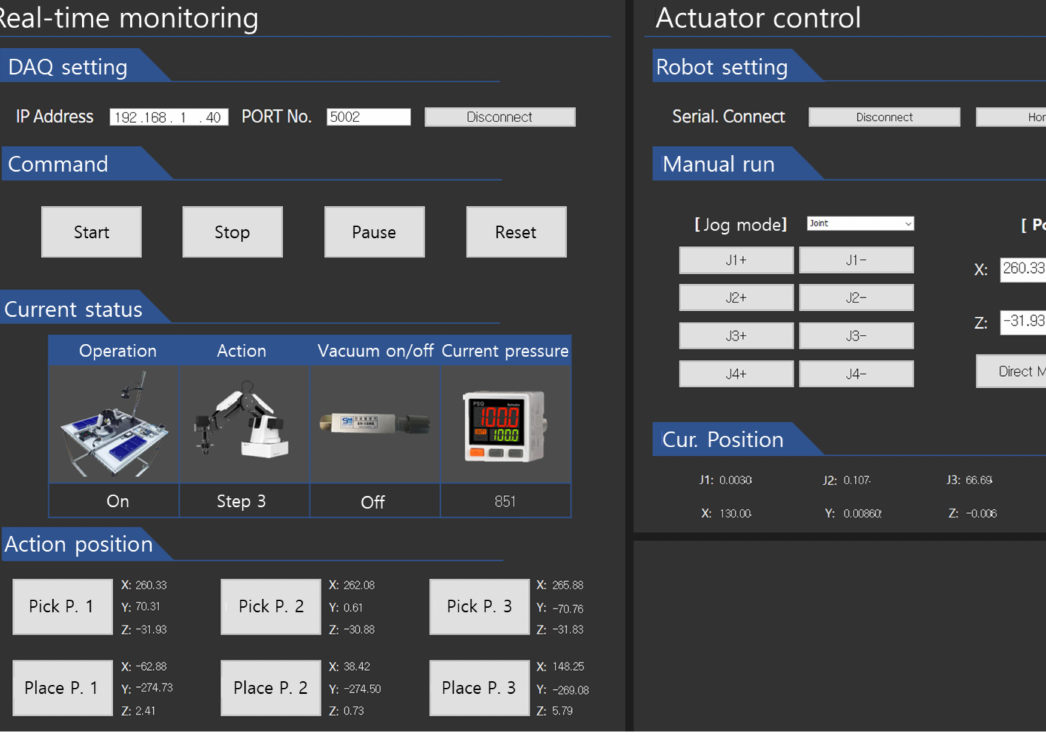
Figure 3. Software to control the testbed, collect sensor signals in real time, and send feedback control